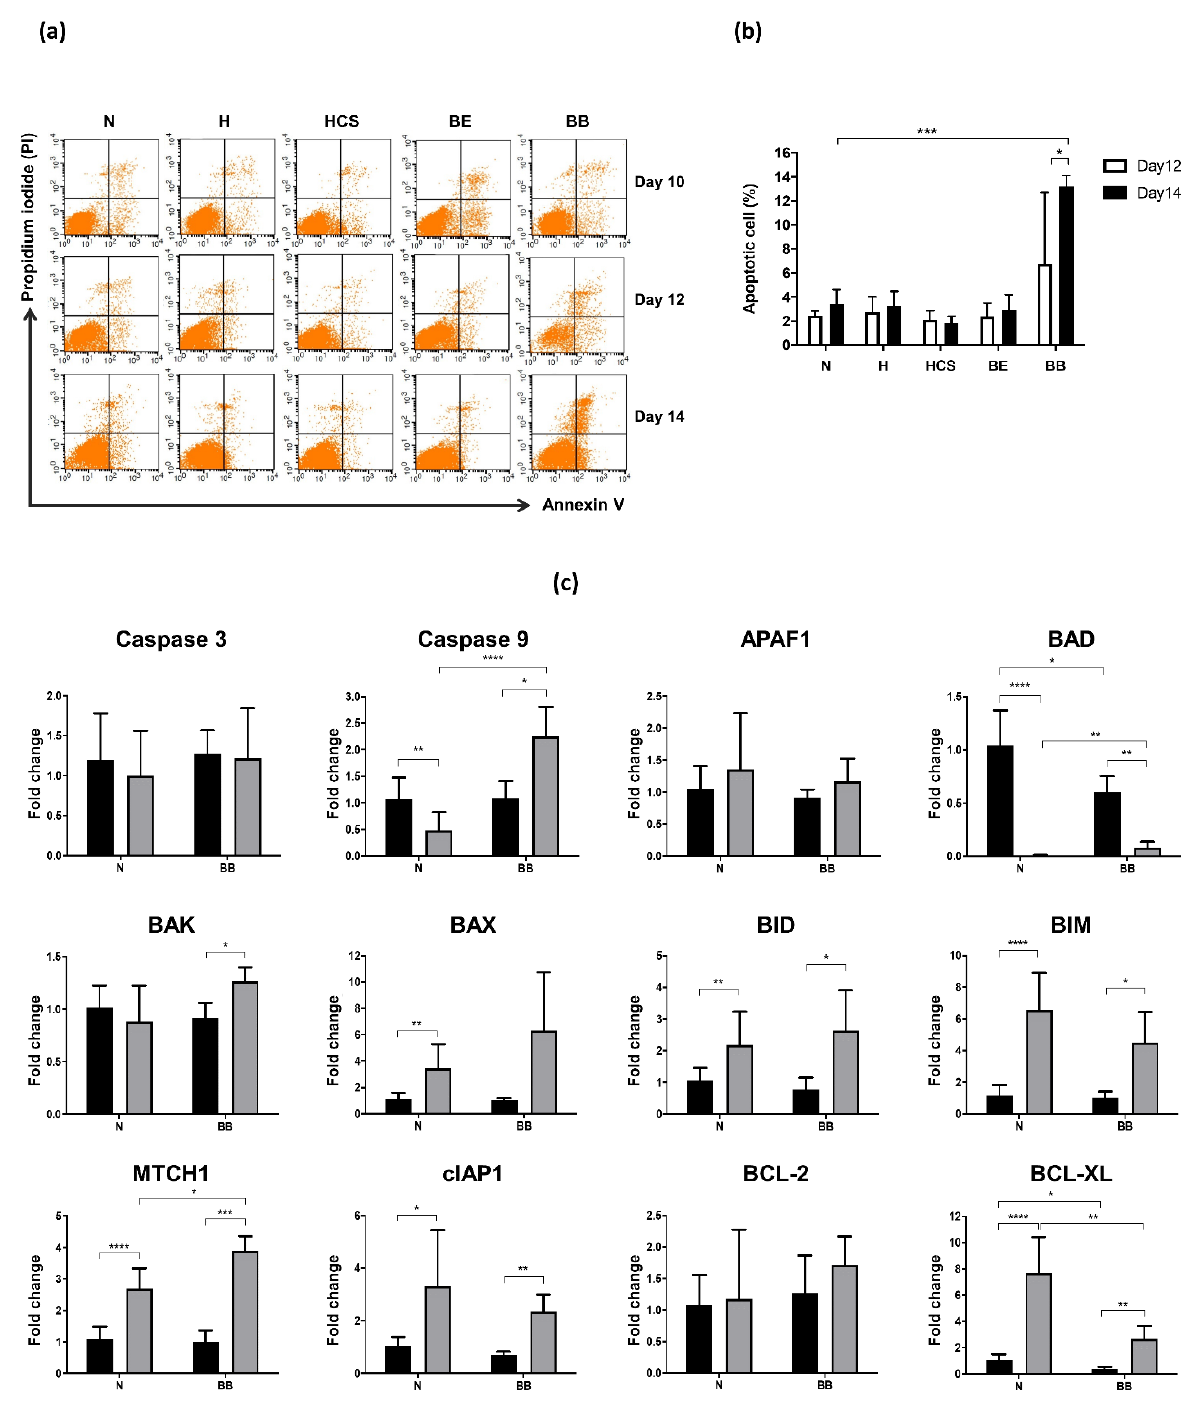
Figure 4. Increased apoptotic cells in the homozygous β 0 -thalassemia erythroid cells during in vitro culture. ( a ) Representative flow cytometry density dot plots of erythroblasts derived from normal control (N), HbH disease(H), HbH-CS disease (HCS), β 0 -thalassemia/HbE disease (BE), and homozygous β 0 -thalassemia disease (BB) on days 10, 12, and 14 of cell culture. ( b ) Percentage of erythroid cells undergoing apoptosis (Annexin V positive and PI positive population) at days 12 (white bar) and 14 (black bar) of culture. ( c ) Quantitative RT-PCR analysis of transcript levels of apoptotic related genes in days 10 (black bar) and 12 (gray bar) of culture. The results were calculated as a fold change to the mean of transcript levels of cells from normal control day 10 of culture. * p ≤ 0.05; ** p ≤ 0.01; *** p ≤ 0.0 01; **** p ≤ 0.0 001.